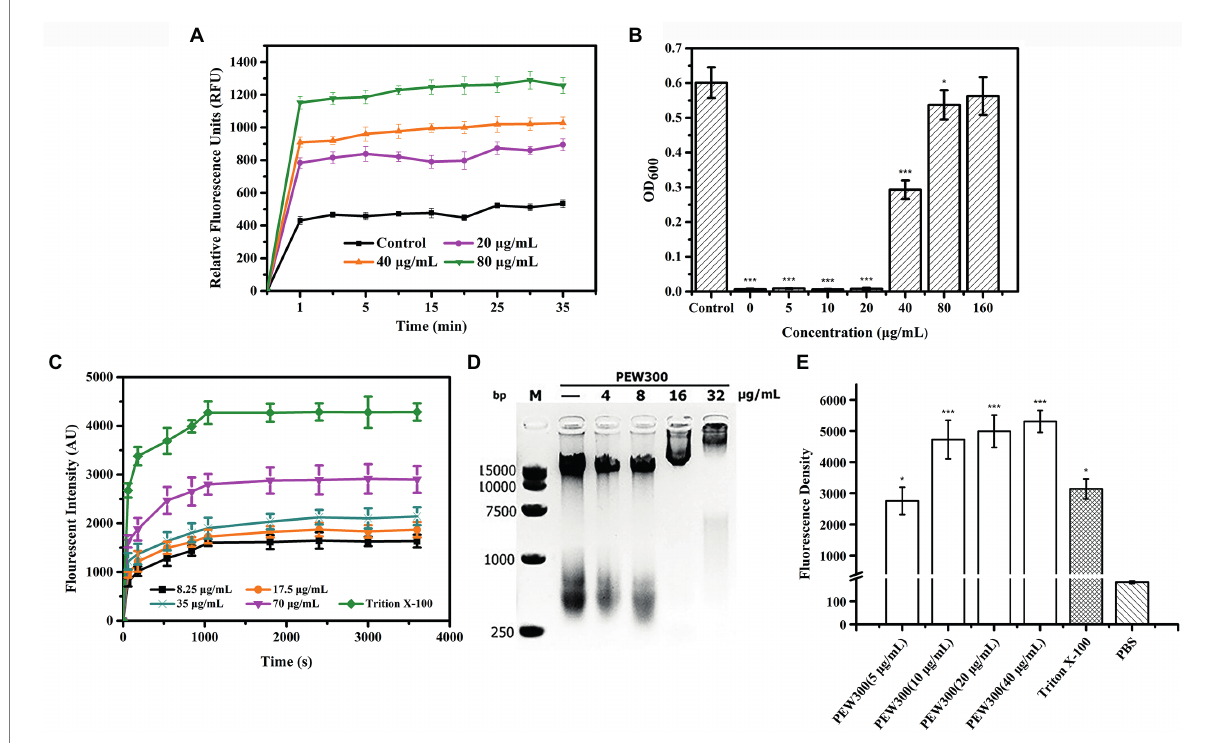
FIGURE 8 Membrane analysis and intracellular disturbance induced by PEW300. (A) Effects of PEW300 on OM permeabilization of Pseudomonas aeruginosa JCM5962. Control represents cells with no PEW300 treatment. (B) LPS-binding affinities of PEW300. Control means the growth of P. aeruginosa JCM5962 with no PEW300 and LPS incubation. * p < 0.05, *** p < 0.005 compared with control. (C) The IM depolarization induced by PEW300. (D) The electrophoretic mobility shift analysis of the interaction between P. aeruginosa JCM5962 genomic DNA (200 ng) and PEW300